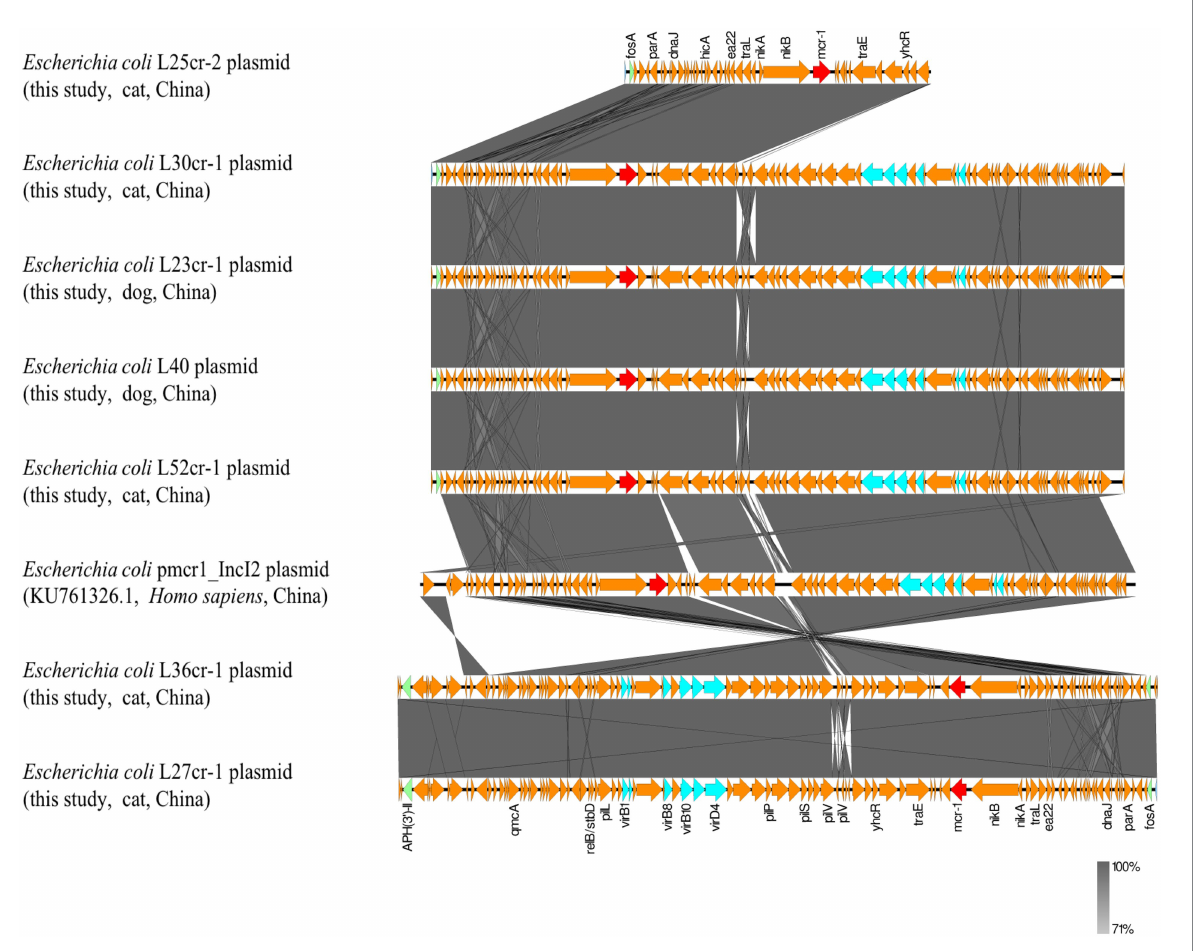
FIGURE 3 Genetic environment analysis of the 7 mcr-1- positive strains from samples obtained from a pet hospital in Shanghai, China, and reference strains. Arrows indicate the transcription direction. Shared regions with a high degree of sequence similarity are indicated in gray. Red arrows denote mcr- 1 , green arrows indicate other antibiotic-resistance genes, blue arrows indicate type IV secretion system genes, and orange arrows indicate other